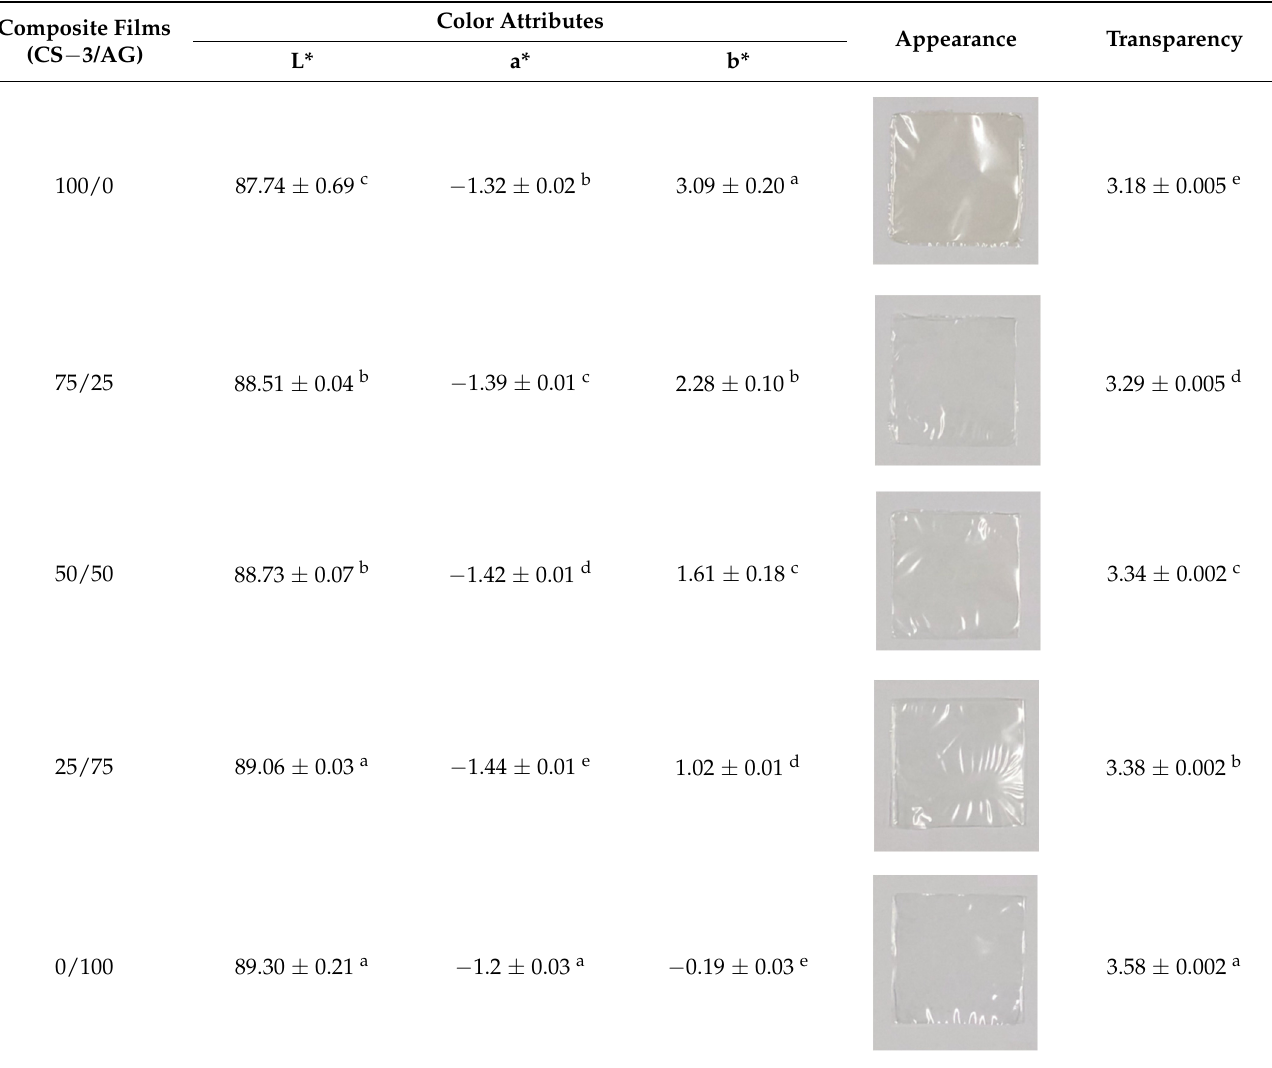
Table 4. Color attributes, appearance and transparency values of CS − 3/AG composite films with various ratios.